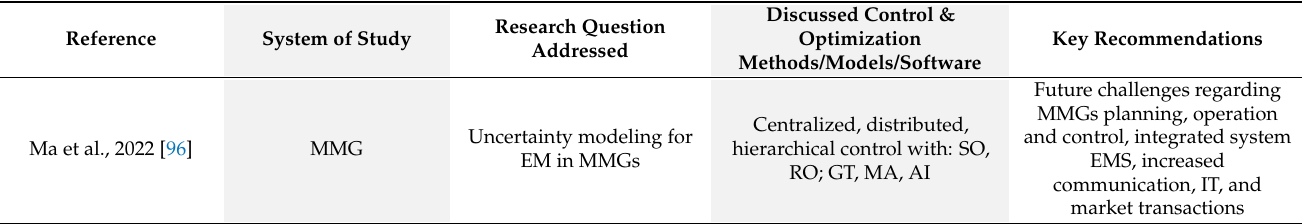
Table 5. Summary of control and optimization methods used for different MG and their